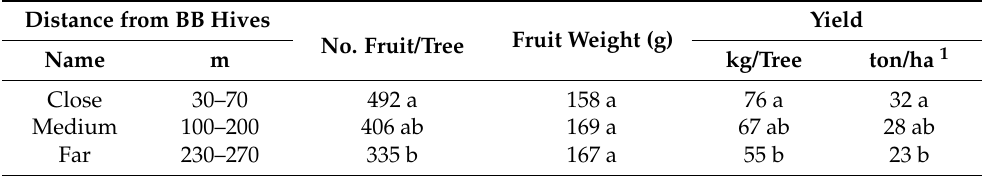
Table 4. Effect of adding bumblebee (BB) hives (April 2018) on the number of fruit per tree, fruit weight and total yield (February 2019) at three distances from the BB hives, Kfar Giladi, 2018/19. Distance from BB Hives Yield No. Fruit/Tree Fruit Weight (g) Name m kg/Tree ton/ha 1 Close 30–70 492 a 158 a 76 a 32 a Medium 100–200